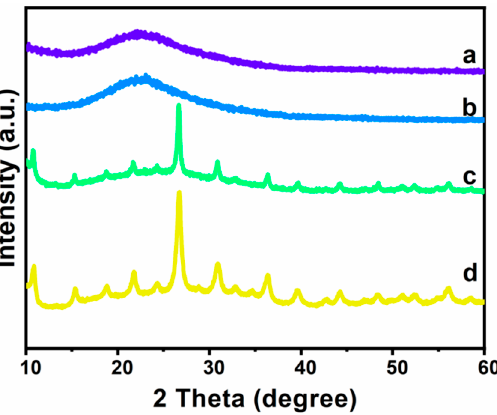
Figure 1. X-ray di ff raction pa tt erns of MCF (a), [BMIM]Cl-based MCF (b), [BMIM] 3 PMo 12 O 40 -based Figure 1. X-ray diffraction patterns of MCF (a), [BMIM]Cl-based MCF (b), [BMIM] 3 PMo 12 O 40 -based MCF (c) and [BMIM] 3 PW 12 O 40-based MCF (d). MCF (c) and [BMIM] 3 PW 12 O 40-based MCF (d).